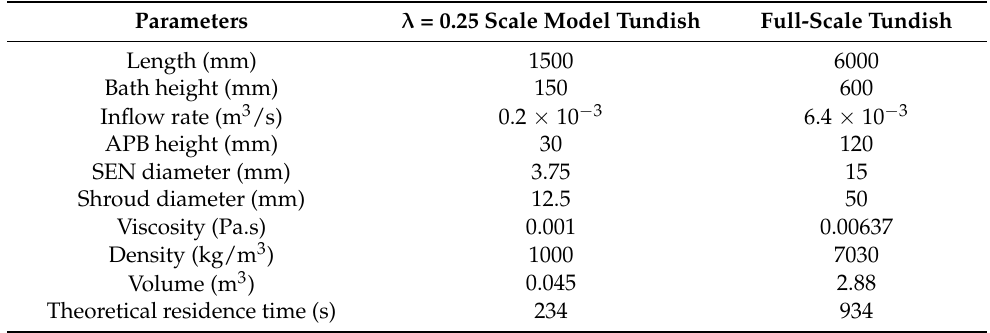
Figure 2. Geometric details of full-scale tundish and advance-pouring box (APB). Table 1. Operating parameters of the tundish.